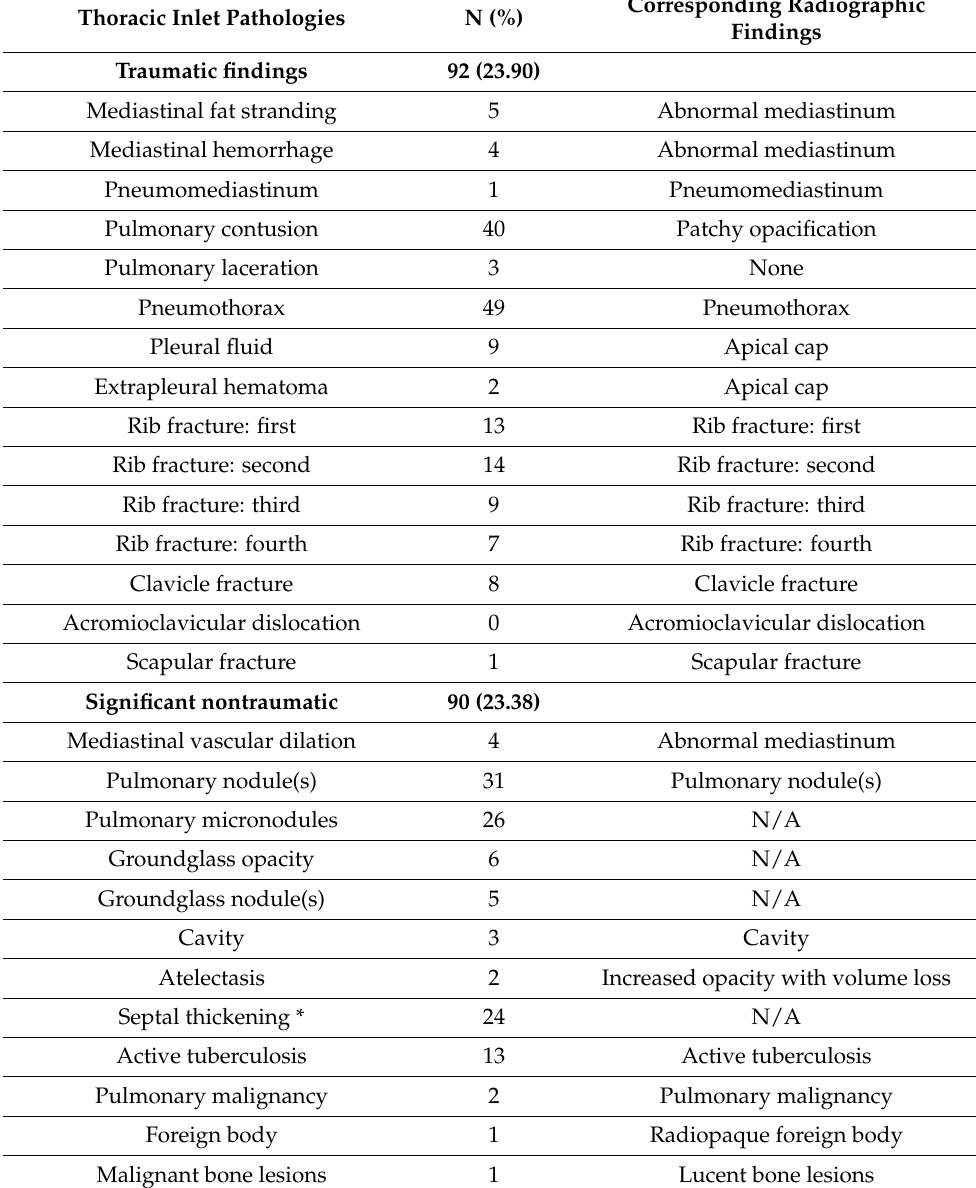
Table 2. Prevalence of thoracic inlet pathologies diagnosed with C-spine CT and their corresponding chest radiographic